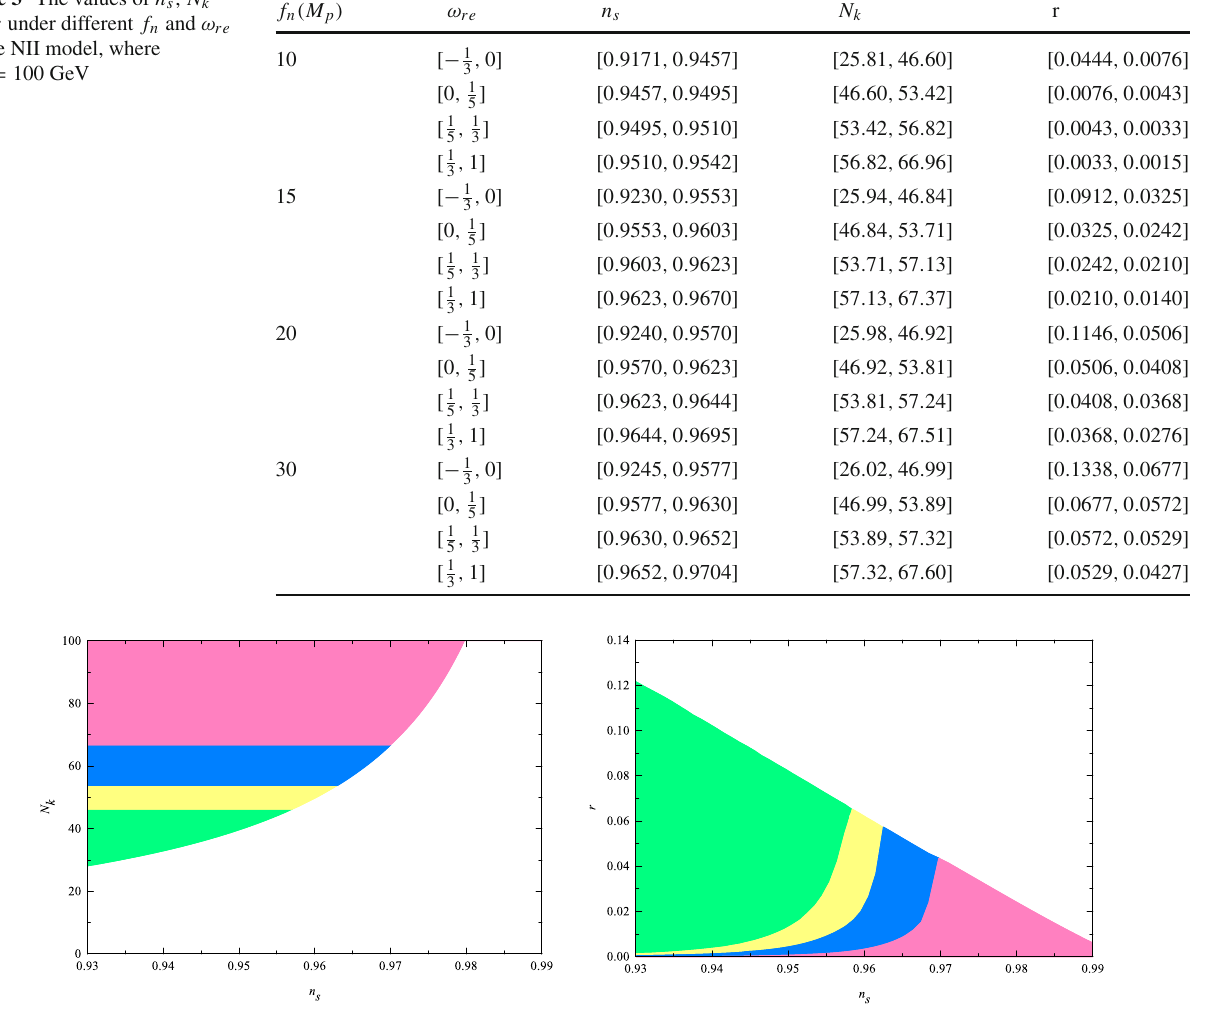
Fig. 8 N k vs n s and r vs n s under NII model, where f n < 30 M p . The legend of the shadow area refer to Fig. 4